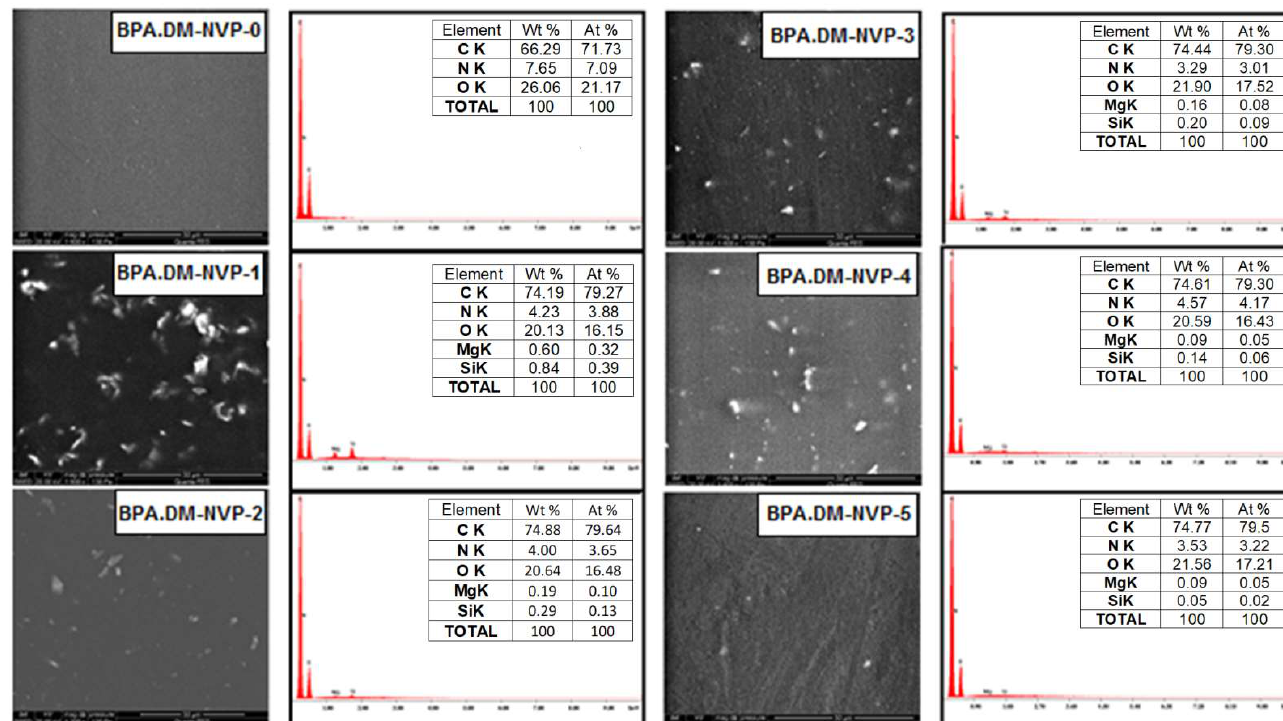
analysis are presented in Figure 5.